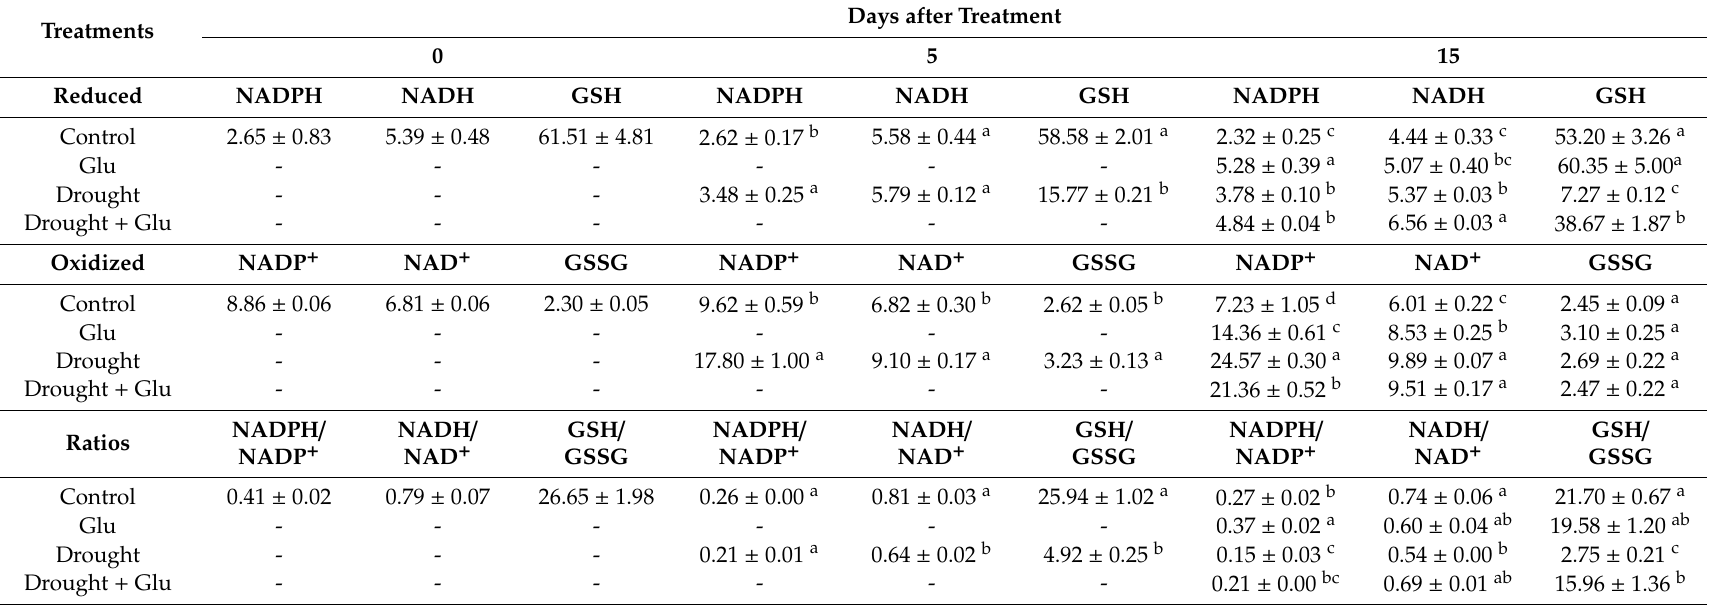
Table 1. Changes in redox status as a ff ected by glutamate (Glu) application in the leaves of Brassica napus under well-watered or drought-stressed